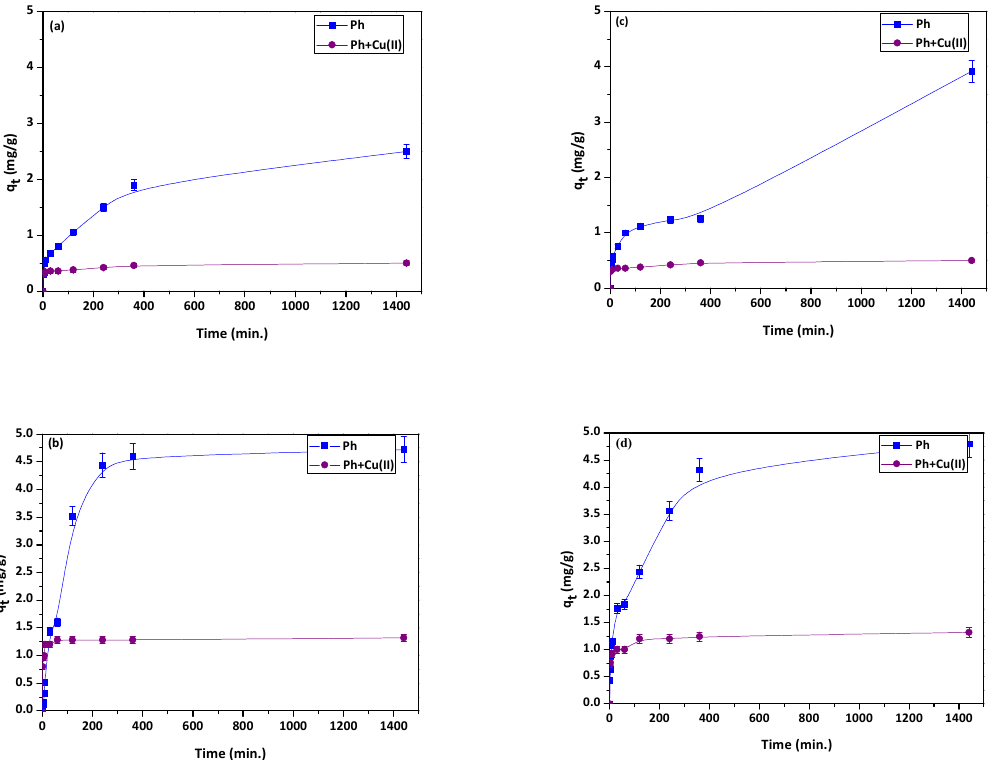
Figure 8. Effect of contact time for the single system of phenol and the dual one of Cu(II) ions and phenol on ( a ) NaP1 C 0 = 50 mg/L; ( b ) NaP1 C 0 = 100 mg/L; ( c ) NaP1CS C 0 = 50 mg/L; ( d ) NaP1CS C 0 = 100 mg/L), m = 0.1g.